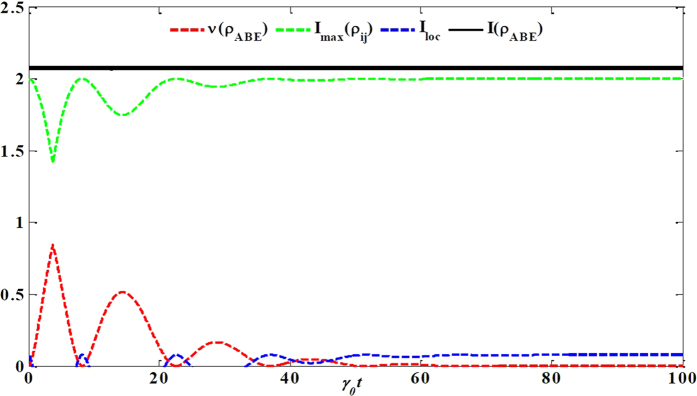
The information flow among the composite system φABE.Genuine tripartite correlations υ(ρABE), maximal bipartite correlations Imax(ρij), local state information Iloc and total state information I(ρABE) versus the scaled time γ0t within the non-Markovian regime for the maximal initial state .